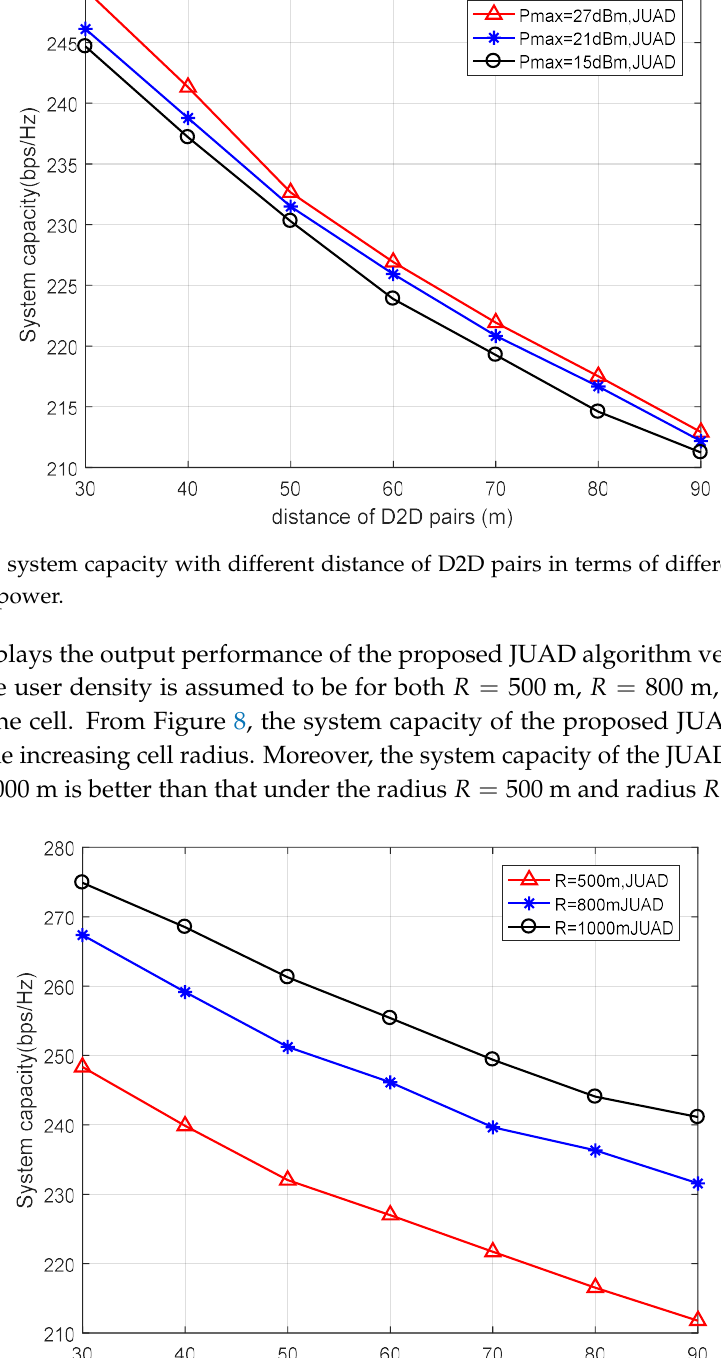
Figure 6. The system capacity with different distance of D2D pairs, comparison of the JUAD/OU/OD resource allocation schemes.